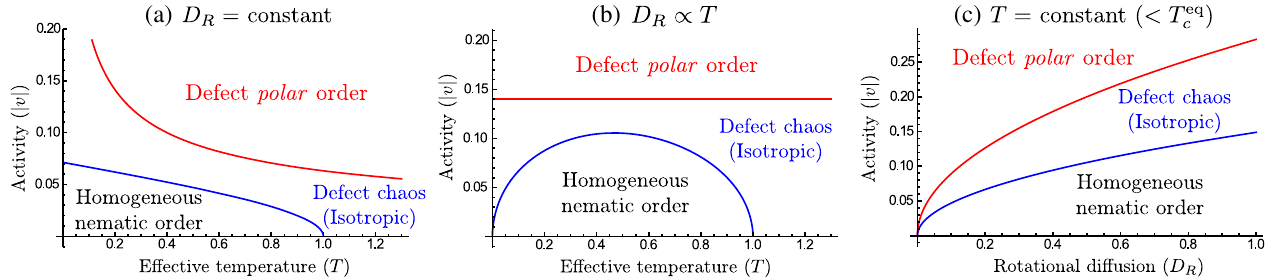
FIG. 3. Full phase diagram as a function of the activity ( j v j ), effective temperature ( T ), and rotational diffusion ( D R ). For the more experimentally accessible phase diagram, with activity ( j v j ) versus liquid-crystal elasticity ( K ), see Fig. 6. We fix ν ¼ π and T eq c ¼ 1 in all the plots. (a) j v j − T plane for fixed D R , (b) j v j − T plane for D R ∝ T showing reentrant melting as a function of T , and (c) j v j − D R plane for fixed T below the equilibrium melting temperature ( T eq c ). Two phase-transition boundaries are marked in all three phase diagrams. The defect-mediated melting transition (blue line) separates homogeneous nematic order from isotropic defect chaos. The defect-ordering transition (red line) separates isotropic defect chaos (active turbulence) from the polar defect-ordered state consisting of a þ 1 = 2 defect flock. A cartoon of the structure of the polar defect flock is sketched in Fig.